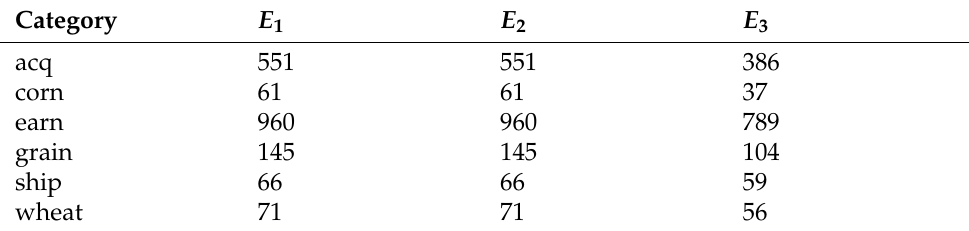
Table 1. Example of the distribution of newswire stories among experts E 1 , E 2 and E 3